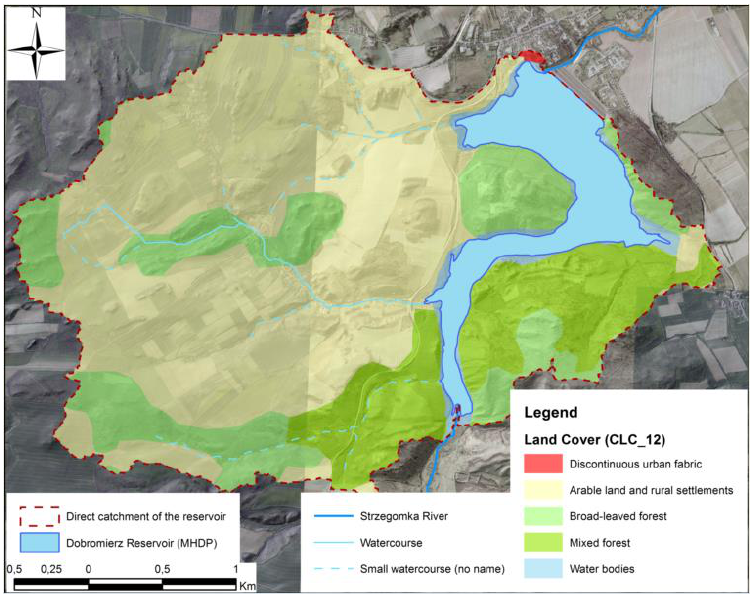
Figure 3. Land use pattern in the direct catchment of the Dobromierz Reservoir.